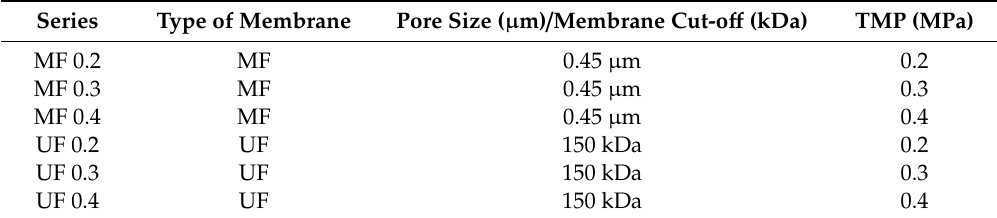
Table 1. Organization of the